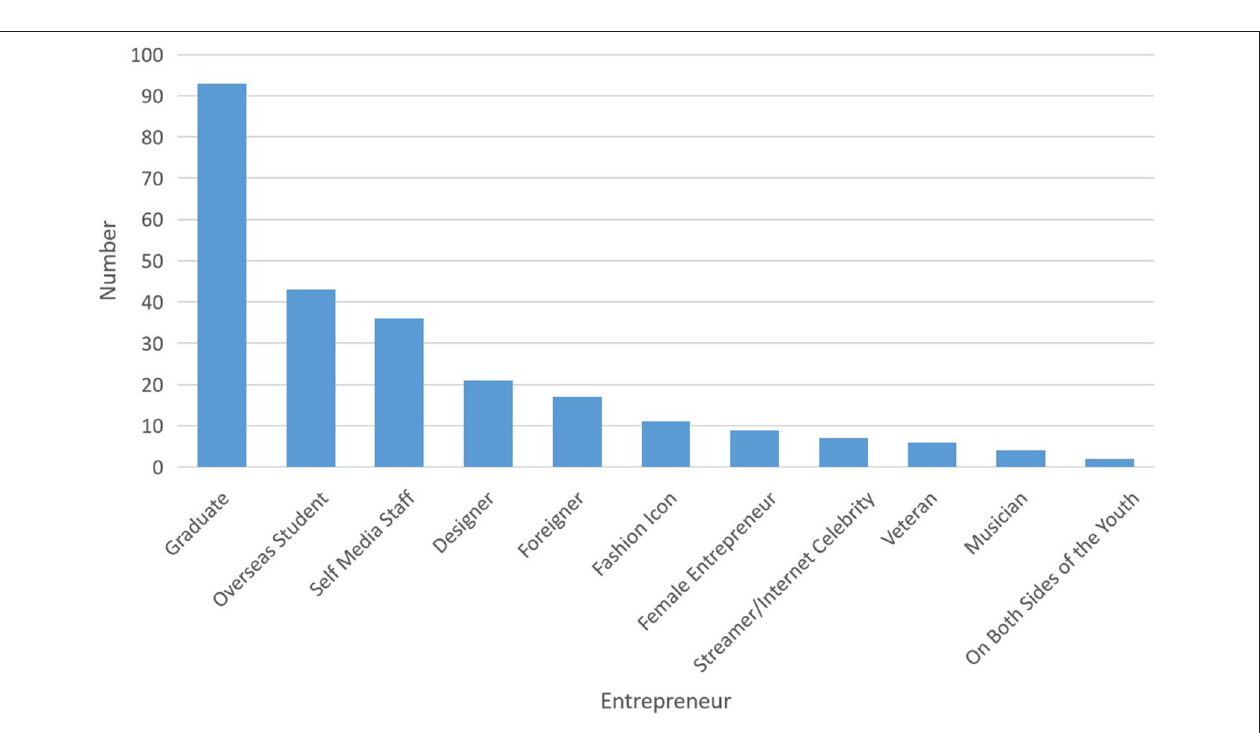
FIGURE 4 | The distribution of entrepreneurs facilitated by